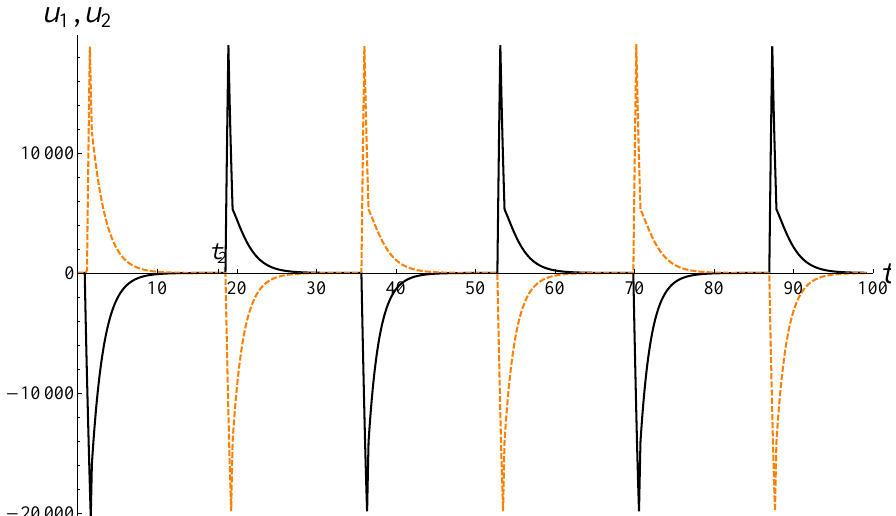
Figure 2. Example of solution. Values of parameters: T = 0.9, γ = − 0.2, p = 1, λ = 10,000. Black line— u 1 ( t ) , orange dashed line— u 2 ( t )